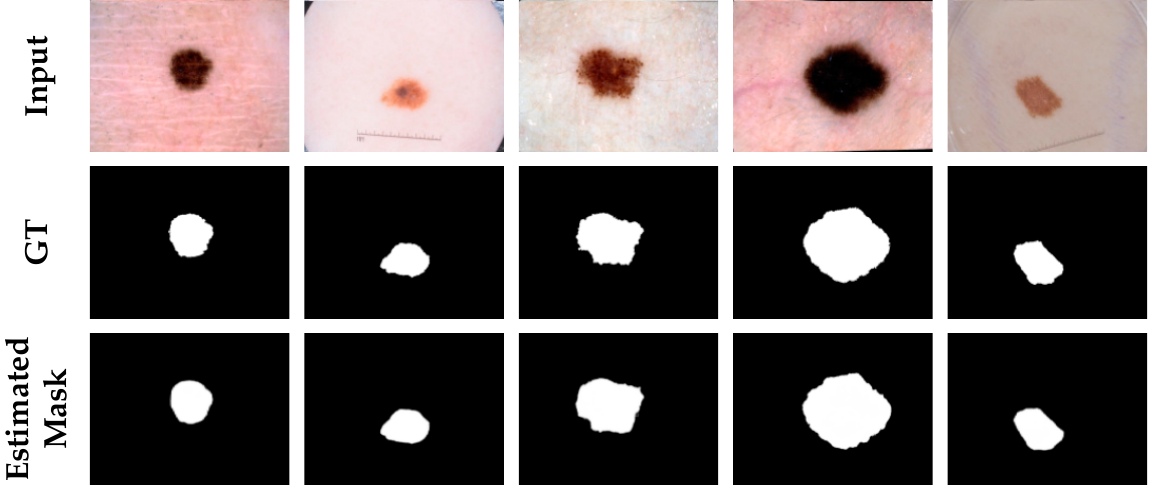
Figure 7. Segmentation results of ASCU-Net on the ISIC-2017 dataset. The first row is the original image. The second row is the skin lesion segmentation ground truth (GT). The third row is the visual segmentation result of the test set of the proposed network.